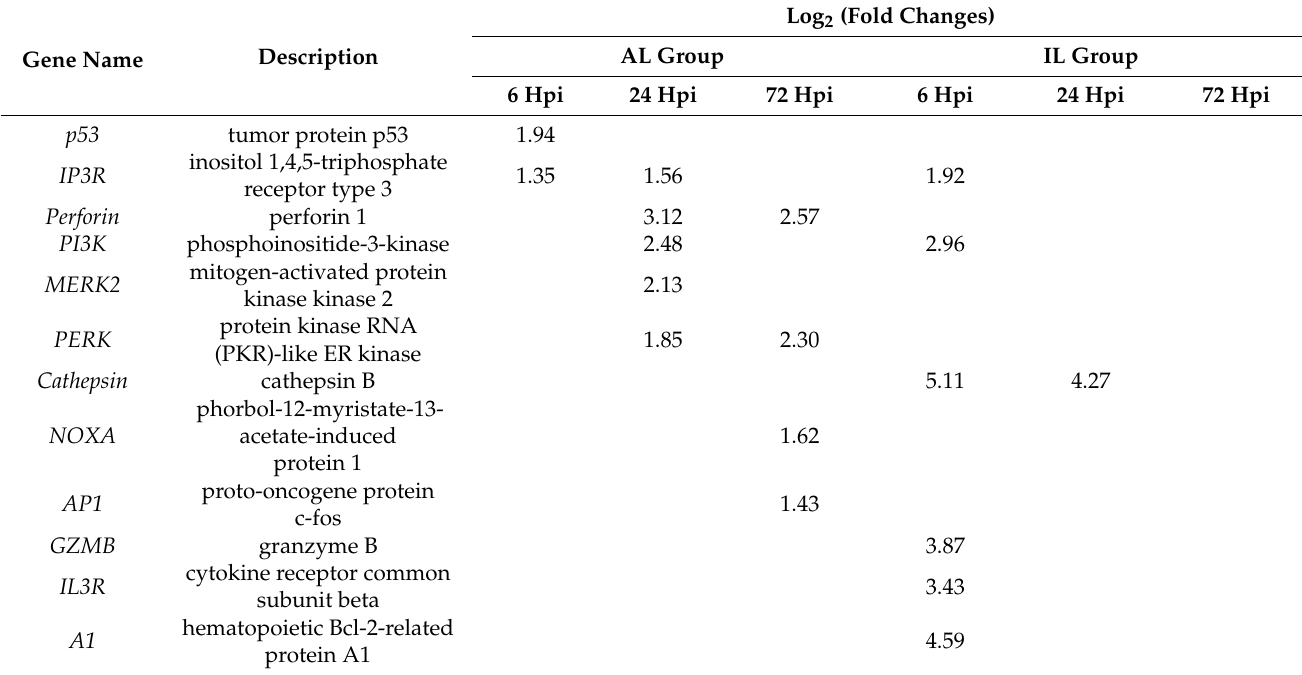
Table 3. Fold changes of up-regulated apoptosis-related genes in the AL group and the IL group compared to the control.